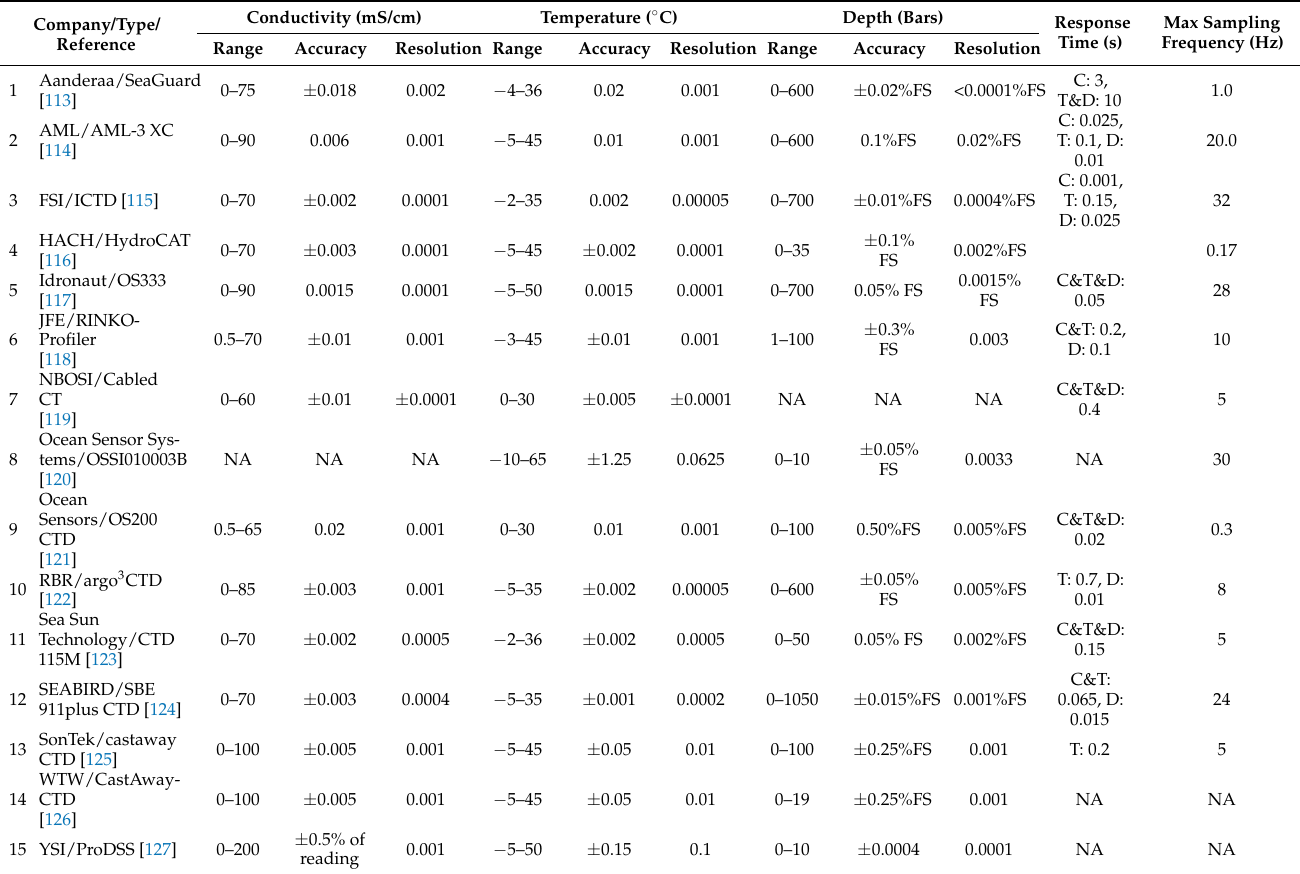
Table 4. Summary of representative commercially-available CTD